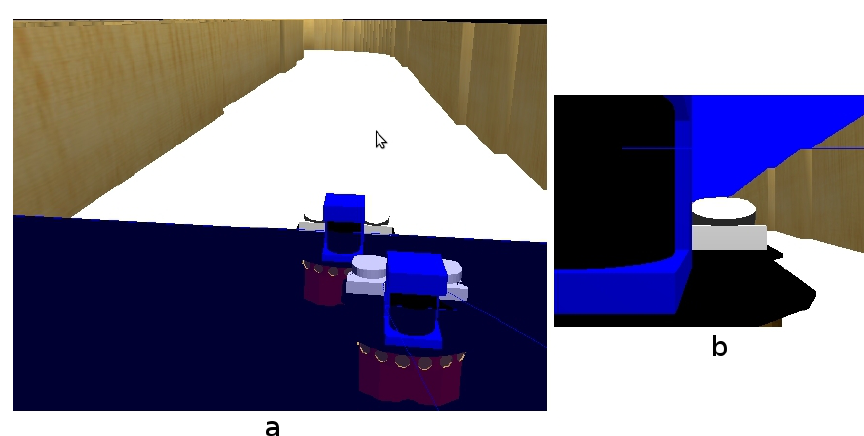
Figure 16. ( a ) Situation; ( b ) Field of view.